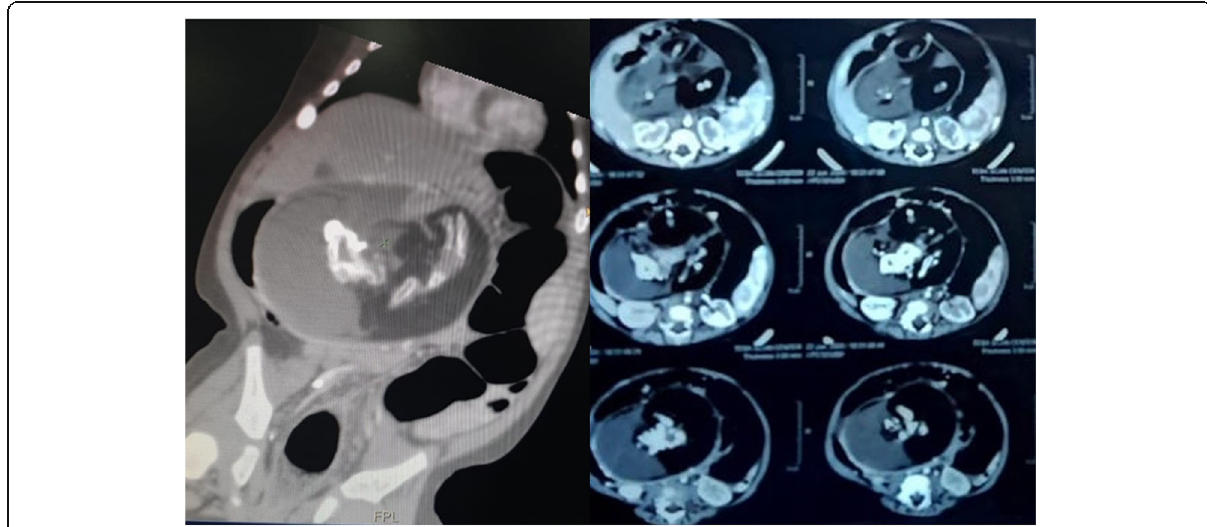
Fig. 4 MDCT showing mixed fat, soft tissue, and bones (vertebral bodies and long bones)